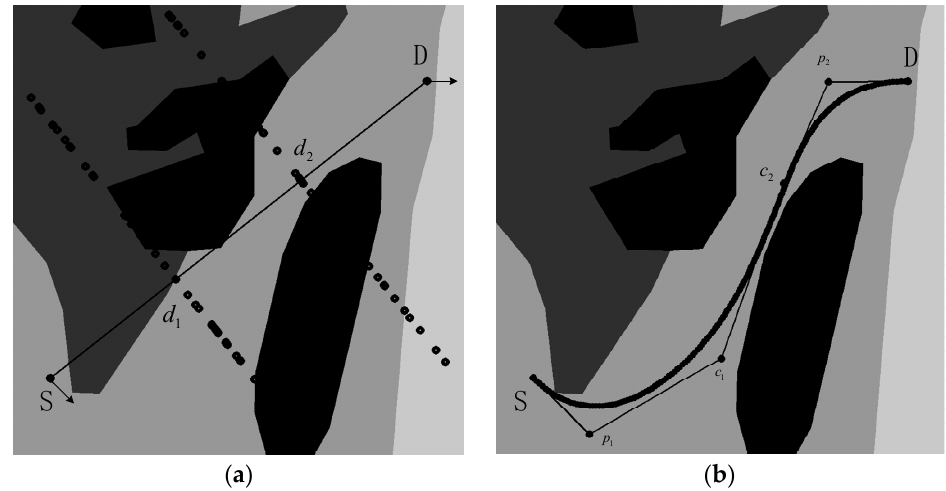
Figure 6. Schematic diagram of B-spline curves ( a ) initializing the swarm ( b ) setting of the fixed control points.